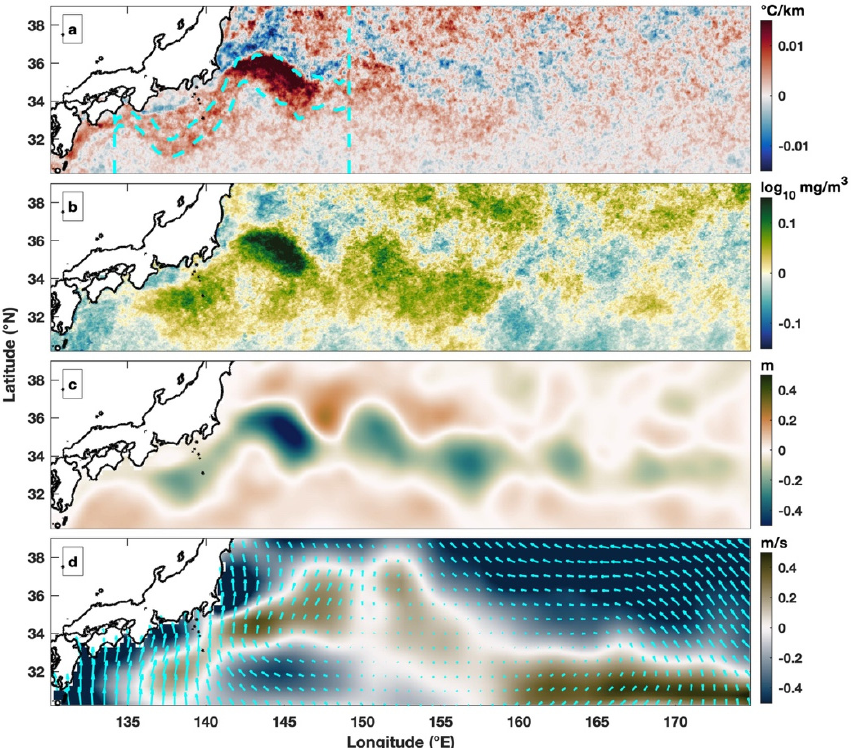
Figure 10. Differences in the ( a ) SST gradient magnitude, ( b ) Chl-a, ( c ) SLA, and ( d ) wind speed overlaid with the wind vector between times when the SST gradient magnitude is abnormally large. The fields are obtained by subtracting the monthly average when the anomaly in the SST gradient magnitude is largely negative from the time when the large anomaly in the SST gradient magnitude is largely positive. The region used to obtain the SST gradient magnitude is shown as the area enclosed by the dashed cyan lines in (a), which is consistent with the region delineated in Figure